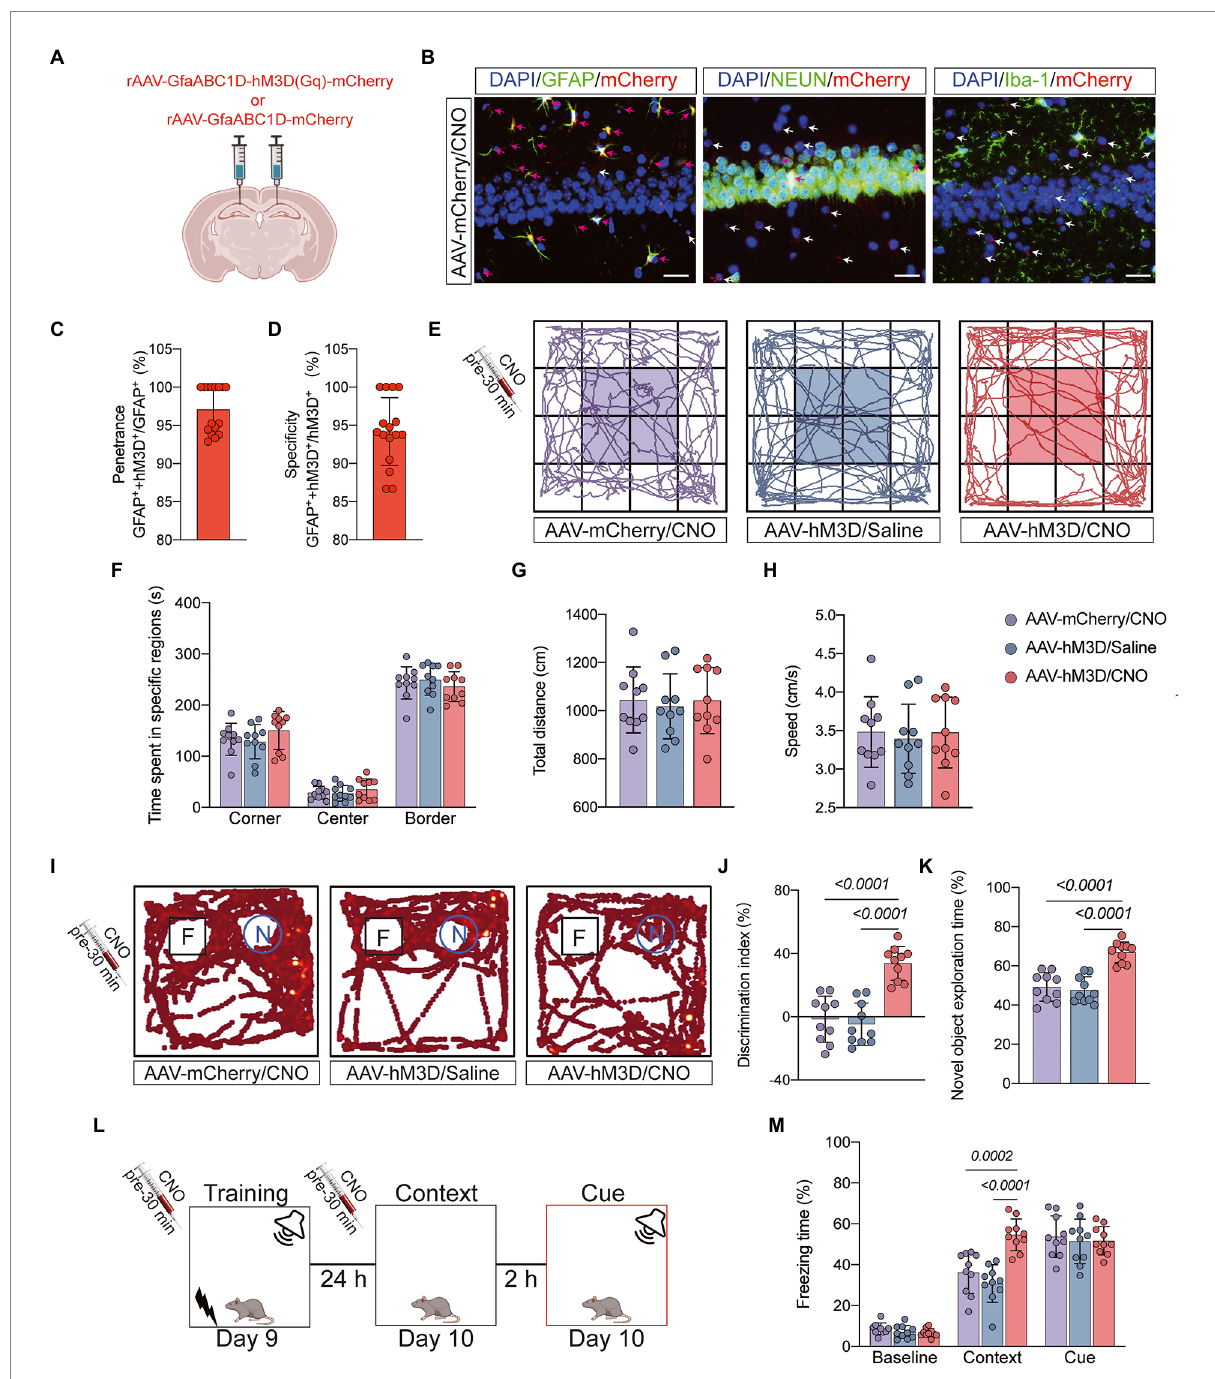
FIGURE 5 Behavioral effects of Gq pathway activation in astrocytes of hippocampal CA1 region. (A) Bilateral hippocampal CA1 regions were injected with rAAV-GfaABC1D-hM3D(Gq)-mCherry ( n = 20) or rAAV-GfaABC1D-mCherry ( n = 10) 21 days before surgery. (B) hM3D(Gq) was specifically expressed in astrocytes. GFAP was used to label astrocytes, NEUN to label neurons, Iba-1 to label microglia, mCherry to label hM3D(Gq), and DAPI to label nuclei, respectively. Red arrows indicate double-staining positivity, while white arrows indicate mCherry single-staining positivity. Scale bar = 25 μ m. (C) The ratio of GFAP and mCherry double-positive cells to GFAP-positive cells is the epistasis rate. (D) The ratio of GFAP and mCherry double- positive cells to mCherry-positive cells is the specificity rate. (E) Locomotor activity was measured on day 7 after tibial fracture by open-field assay after 30 min of intraperitoneal injection of CNO or saline. (F–H) Quantification of total distance travelled, speed of movement, and time spent moving in specific areas in 3 groups of mice. (I) Novel object recognition tests were performed on the 7th and 8th day after tibial fracture. (J,K) Quantitative analysis of discrimination index and percentage of new object recognition in the 3 groups of mice. (L,M) Three cycles of training were performed on postoperative day 9, and the percentage of freezing time was assessed on day 10 in the Context test and the Cue test. Data were expressed as mean ± SD and analyzed by ANOVA test with a Tukey post hoc test. The p -values are shown in the